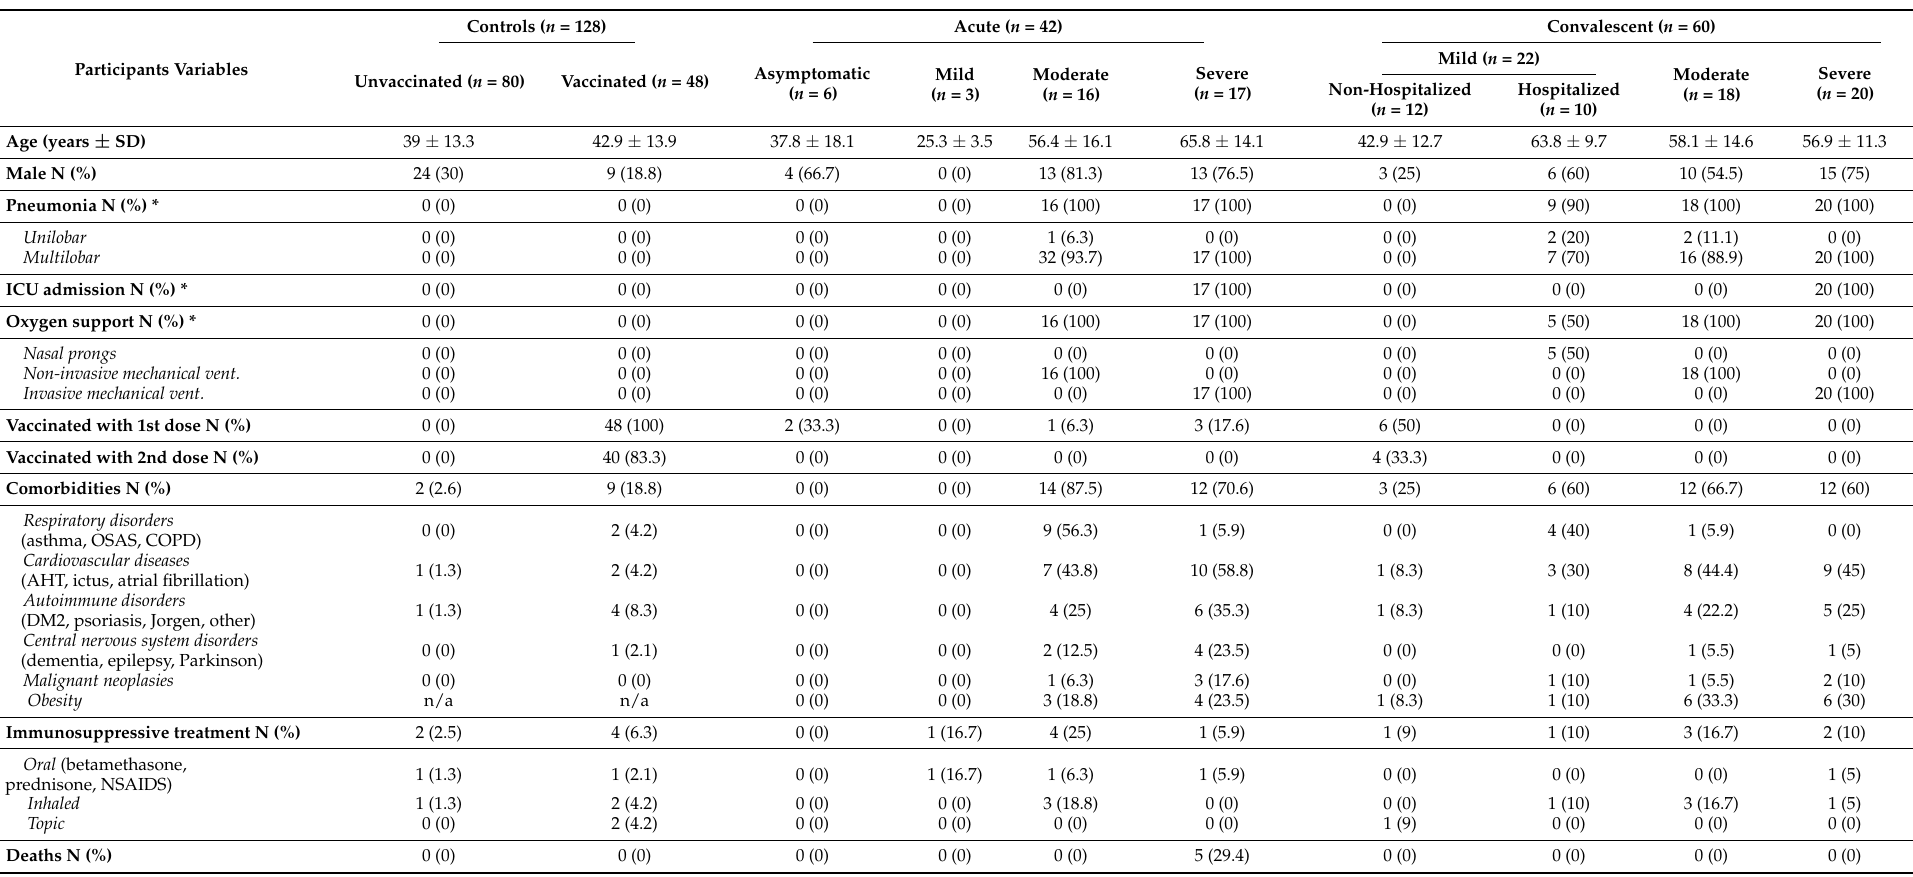
Table 1. Descriptive table from the patients included in the